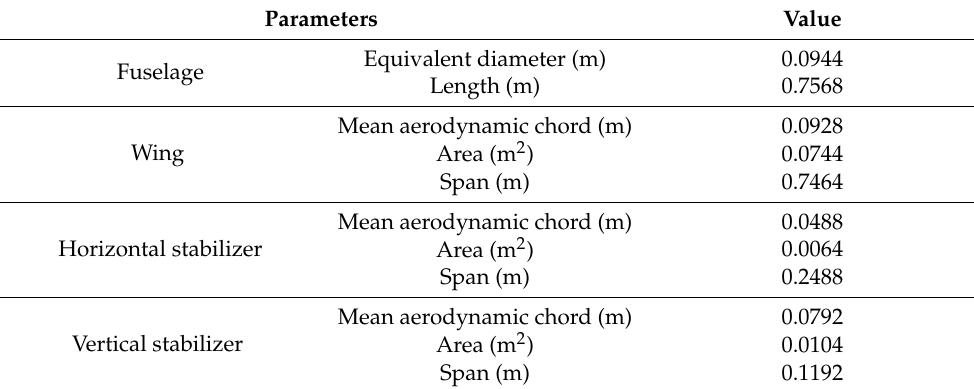
Table 2. Parameters of the wing–body configuration.